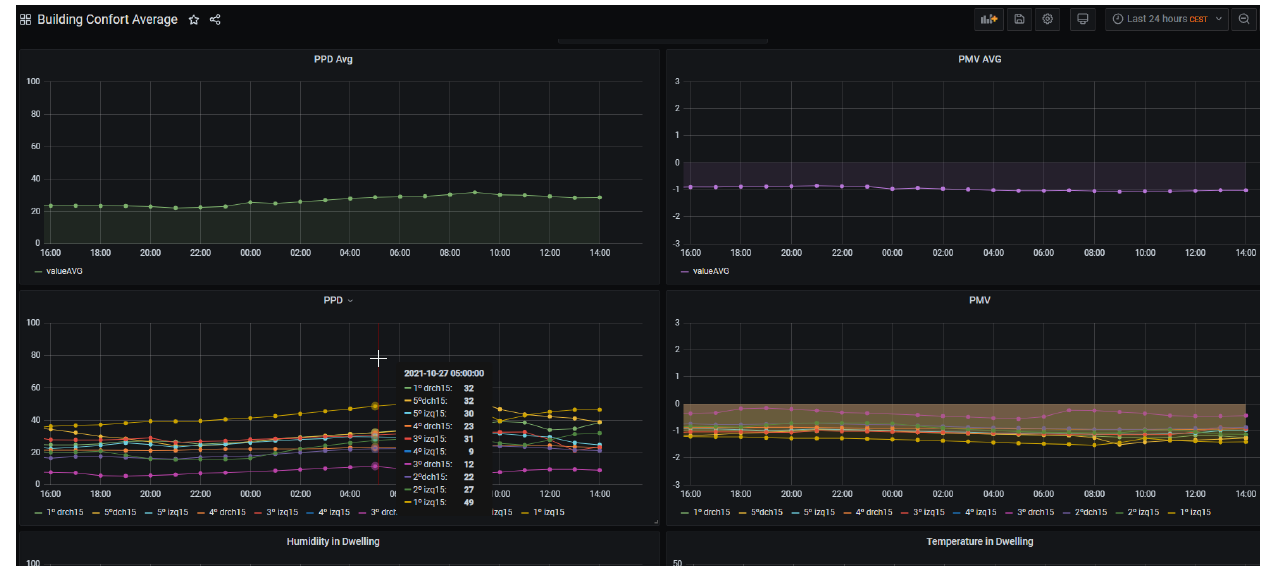
Figure 7. Comfort Dashboard in